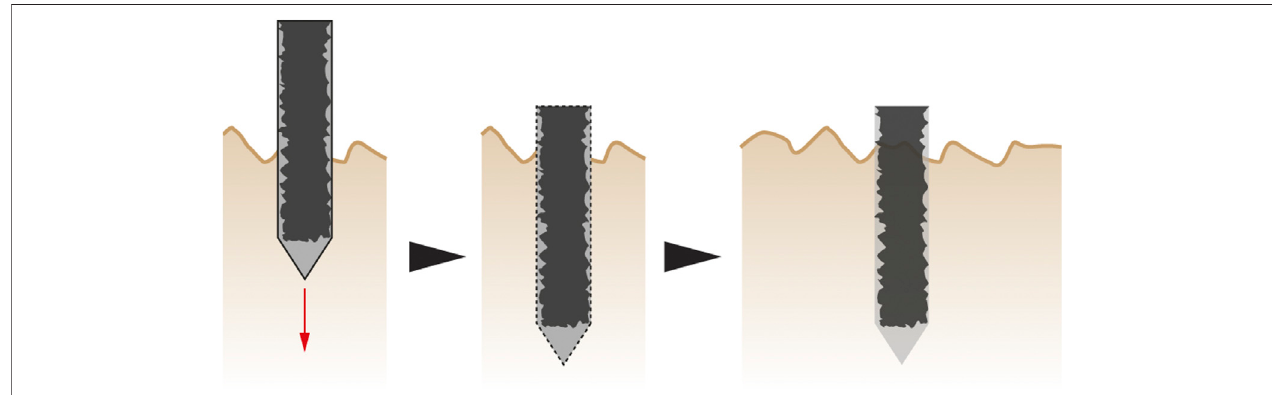
FIGURE 6 | Texture alteration concept — First, the smooth foundation pile is driven into the soil (left) . Over time, the biodegradable material will decay (middle) , leaving the highly textured surface in contact with the soil particles (right) .